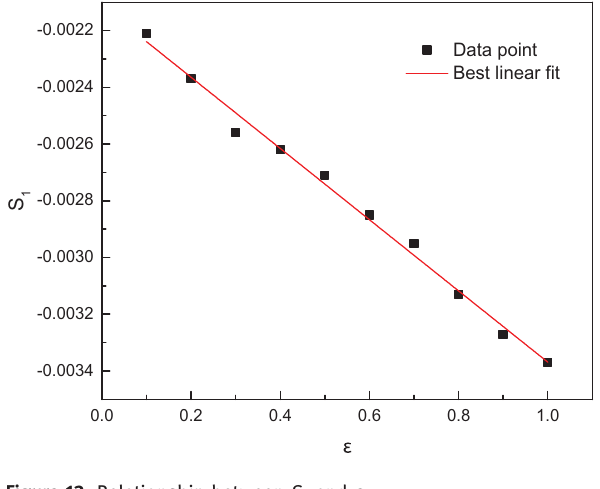
Figure 13: Relationship between S 1 and ε .